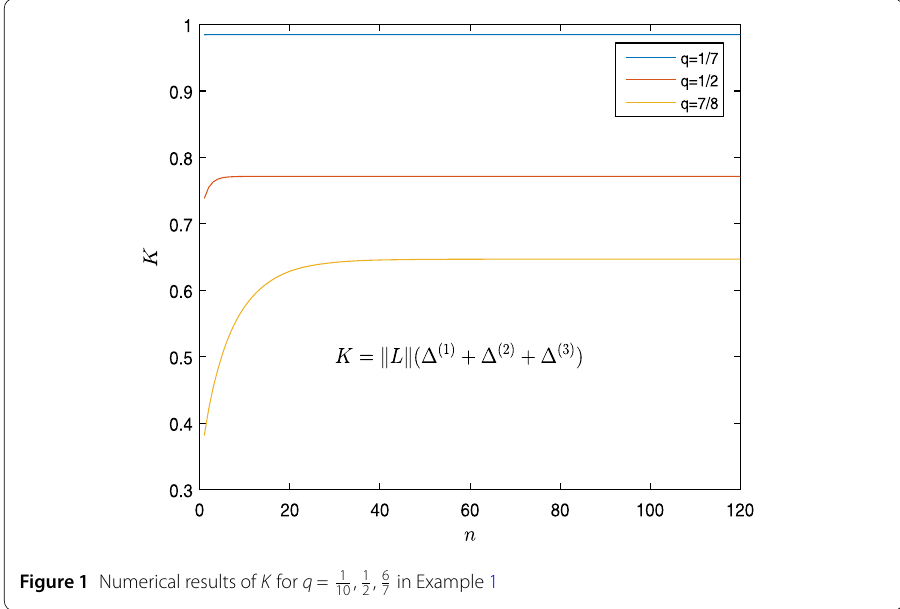
Figure 1 Numerical results of K for q = 1